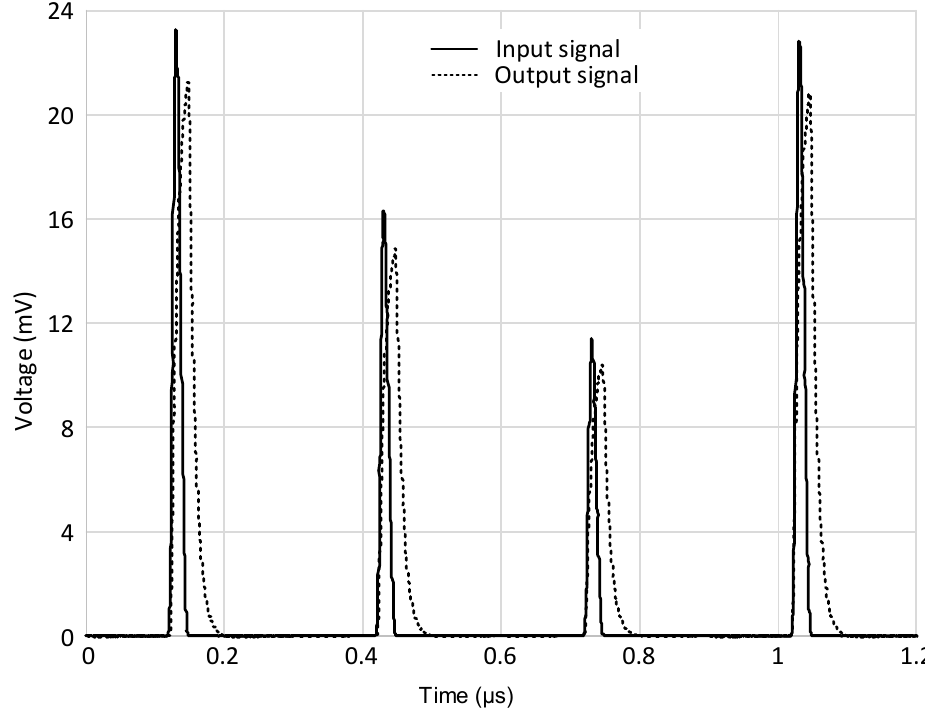
Figure 13. Multi-pulse variable input signal (continuous line) and measured output response (dotted line) of the discrete interface.